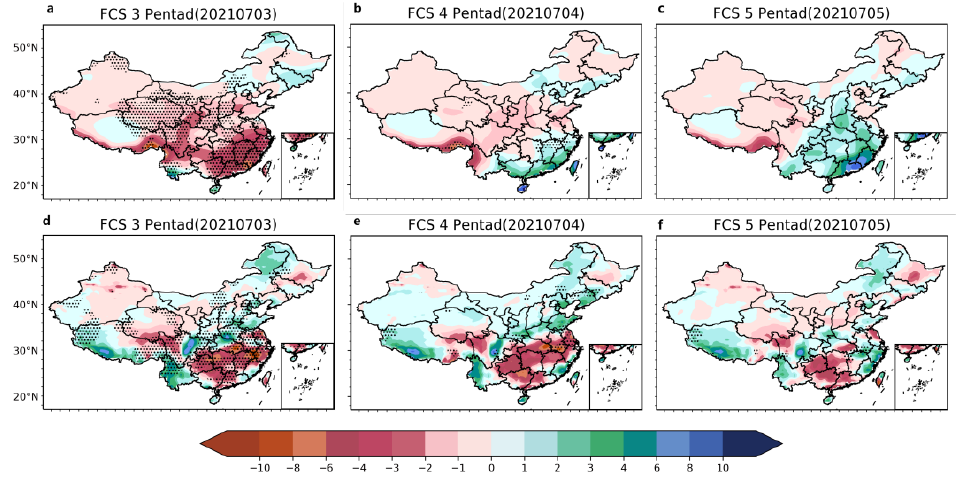
Figure 13. Spatial patterns of the ( a – c ) FGOALS-f2 and ( d – f ) pentad DSDM forecasts from the third to fifth pentads of July 2021 (the initial pentad was the last pentad of June 2021 (26 – 30 June). The dotted areas indicate that the TCC passed the 95% significance